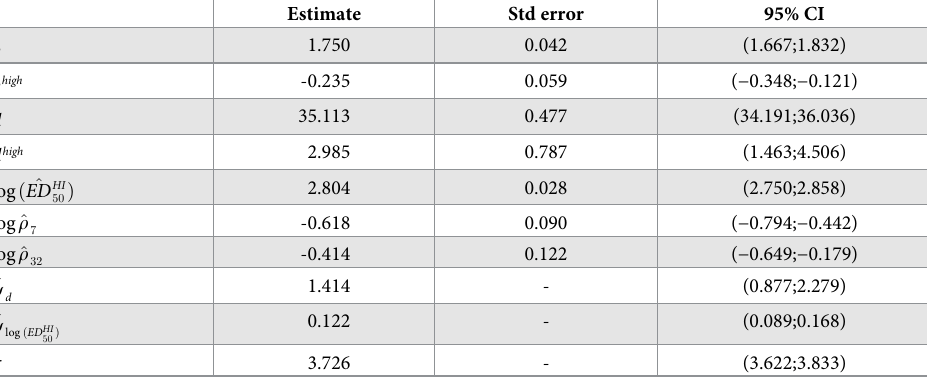
Table 1. Estimates, standard errors and 95% confidence intervals for the parameters from the mixed-effects model. Only the relative log-potency for two insulin analogues are presented here, log ^ r (study